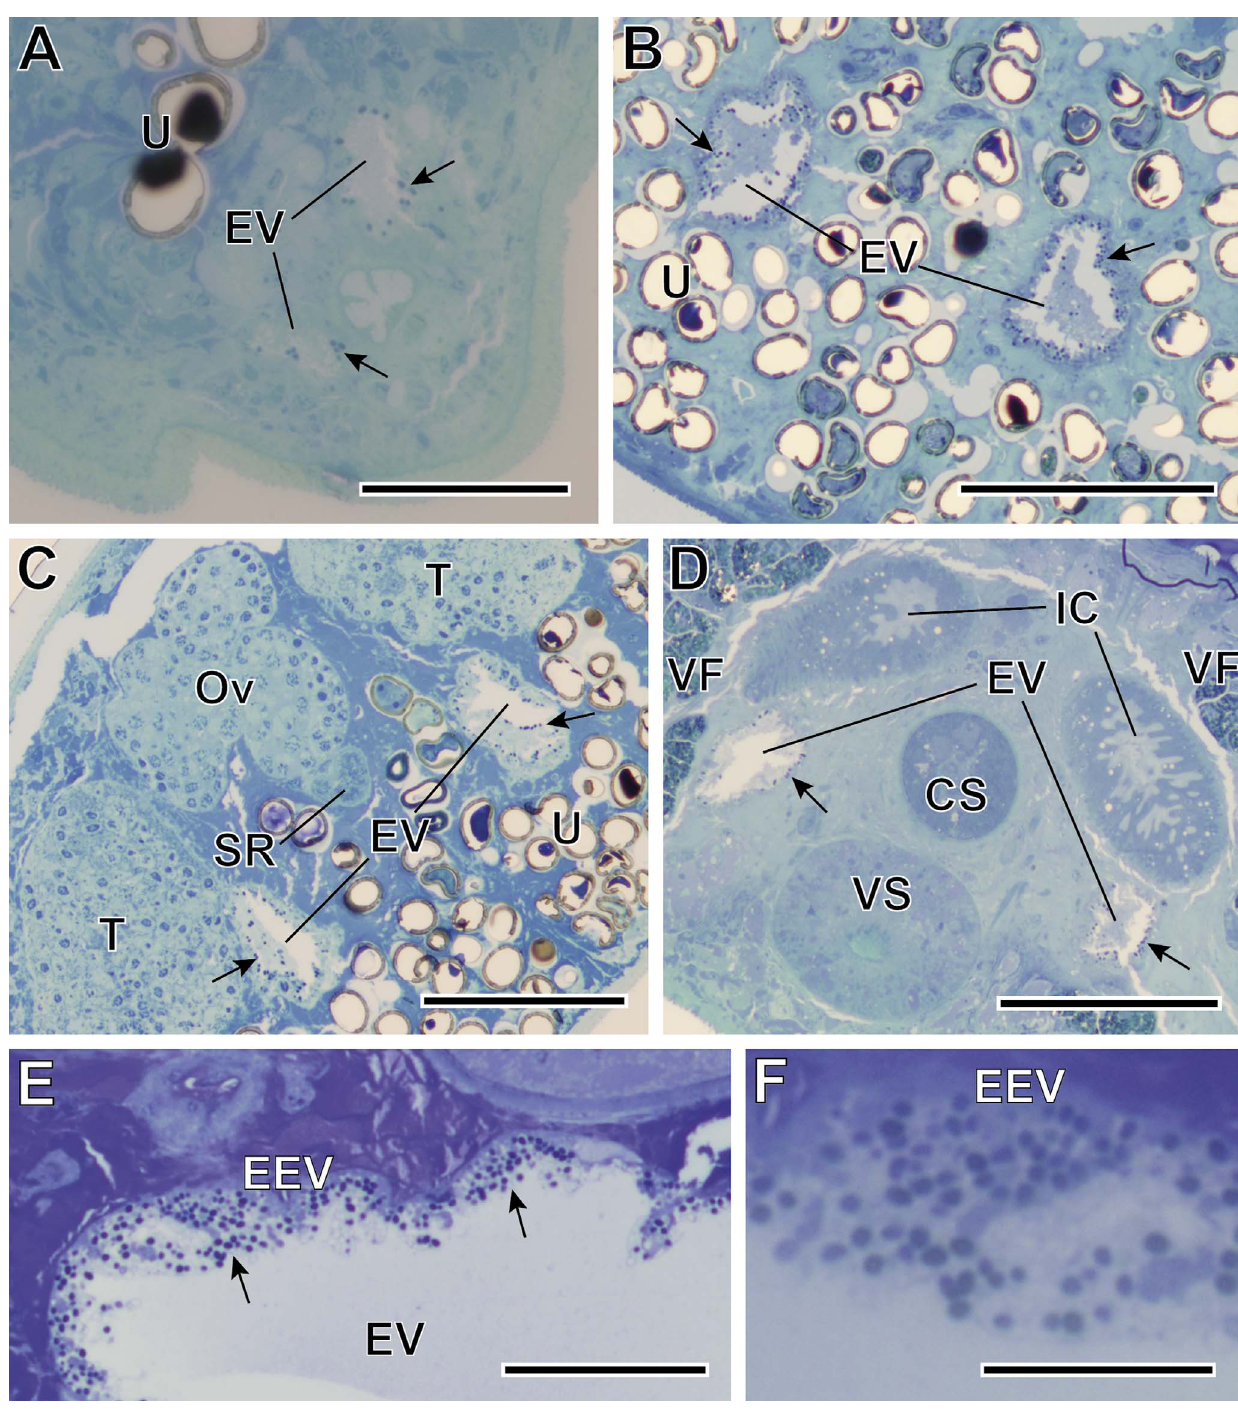
Figure 2. Semithin sections of Bacciger israelensis stained with methylene-blue at different levels showing the presence of many spores (black arrows). (A – B) Sections at 35 and 155 l m from the posterior extremity of the digenean showing the two arms of the Y-shaped excretory vesicle (EV); (C) Section at 210 l m from the posterior extremity at the level of genitalia, showing both testes (T) and the characteristic trilobed ovary (Ov); (D) Section at 310 l m from the posterior extremity at the level of the ventral sucker (VS) and the cirrus sac (CS); (E) Detail of the excretory vesicle at 150 l m from the anterior extremity showing numerous T. baccigeri n. gen., n. sp. in its epithelium (EEV); (F) Enlarged detail of the epithelium of the excretory vesicle. IC, intestinal caeca; SR, seminal receptacle; U, uterus; VF, vitelline follicles. Scale bars: A, E = 50 l m; B – D = 100 l m; F = 20 l